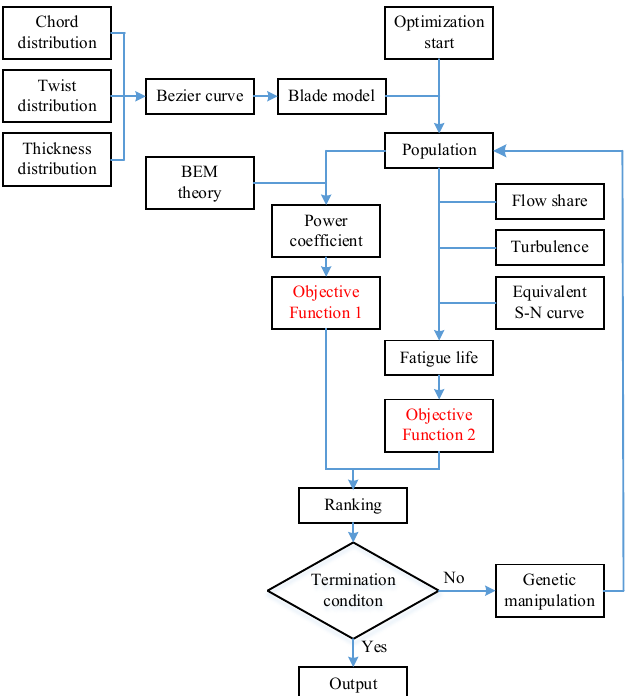
Figure 10. Blade optimization schematic.